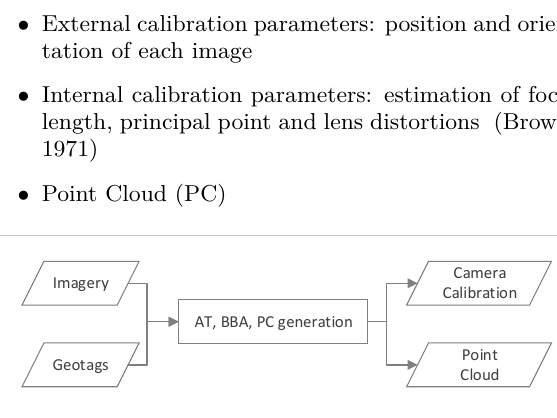
Figure 5. Camera calibration and PC generation